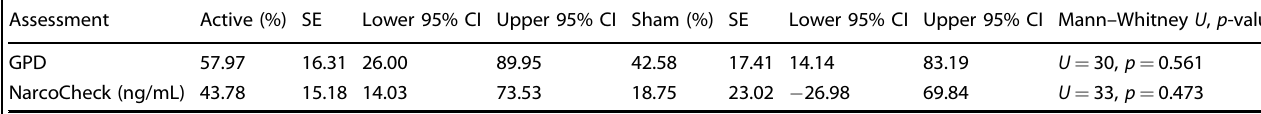
Table 2. Cannabis reduction rates determination outcomes.